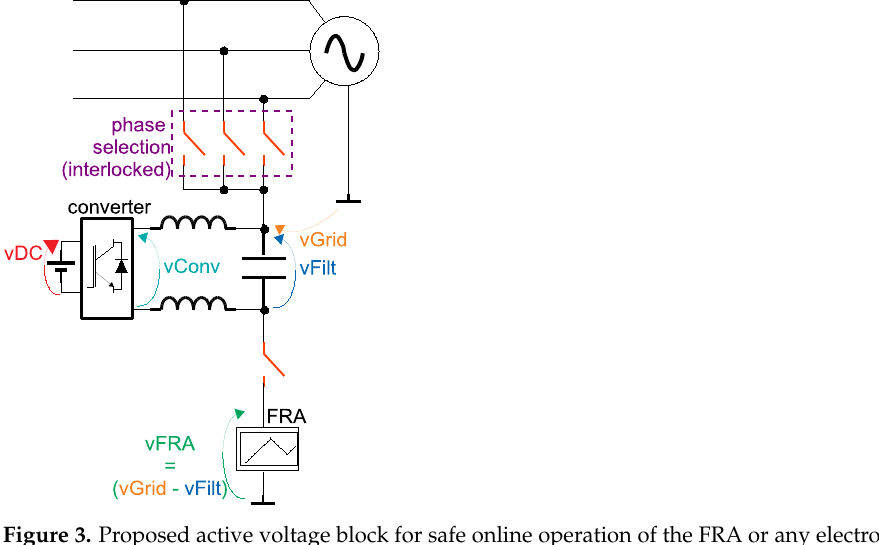
Figure 3. Proposed active voltage block for safe online operation of the FRA or any electronic system operating at a higher frequency than the